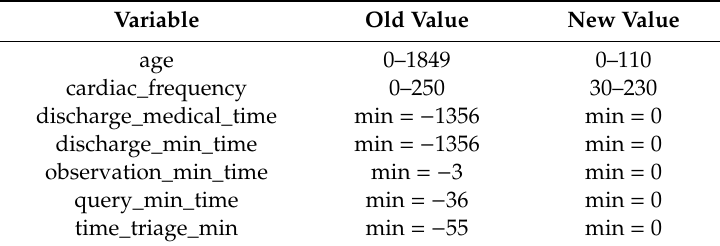
Table 3. Variable interval modifications.